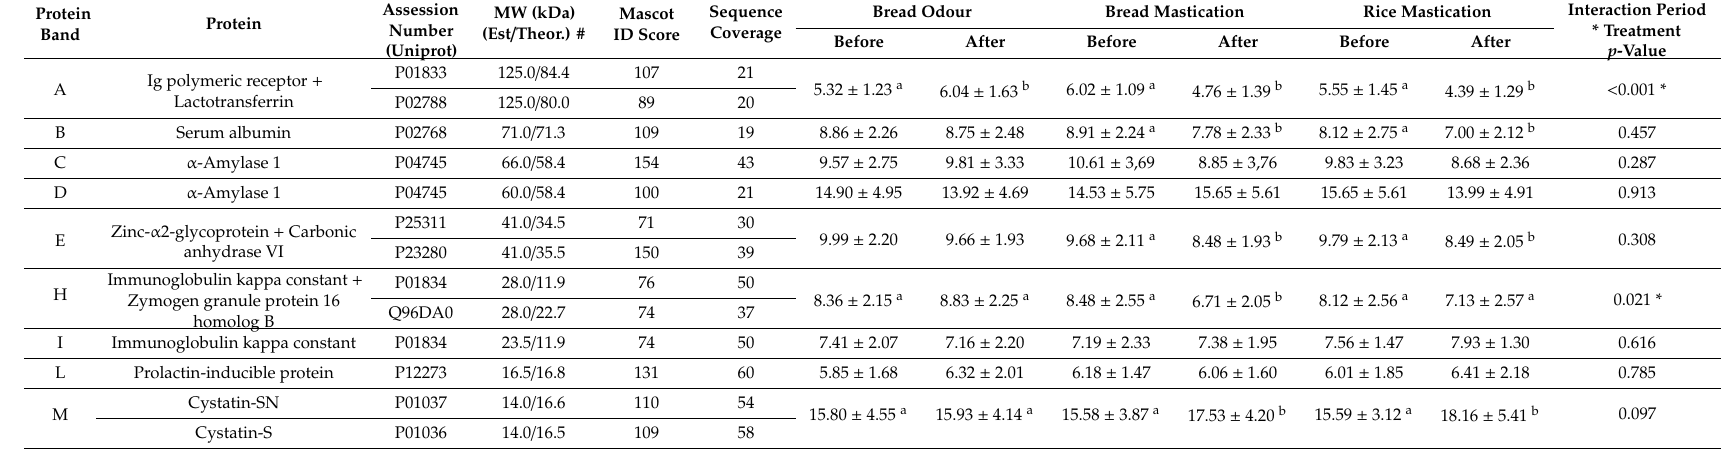
* Treatment p -ValueBefore After Before After Before After